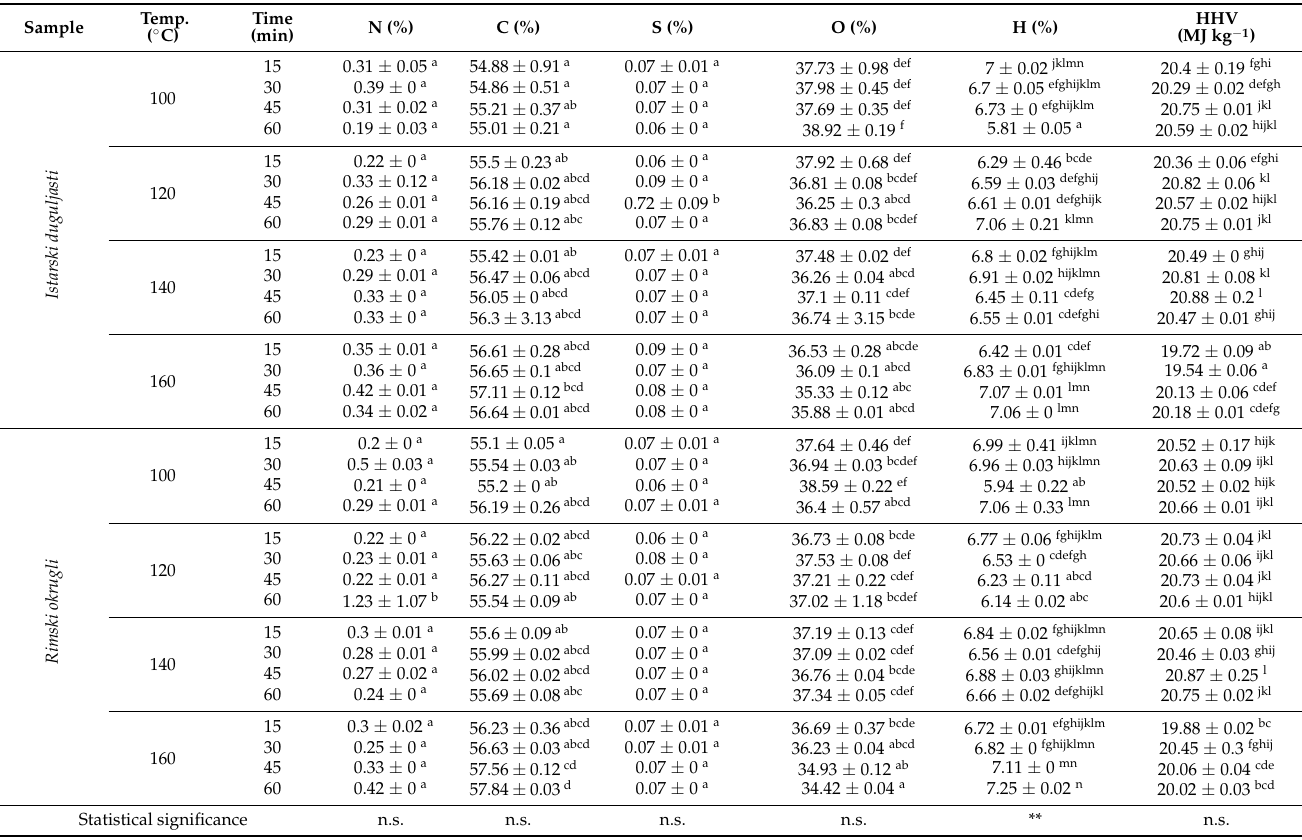
Table 5. Ultimate and calorimetric analysis of observed hazelnut varieties after drying